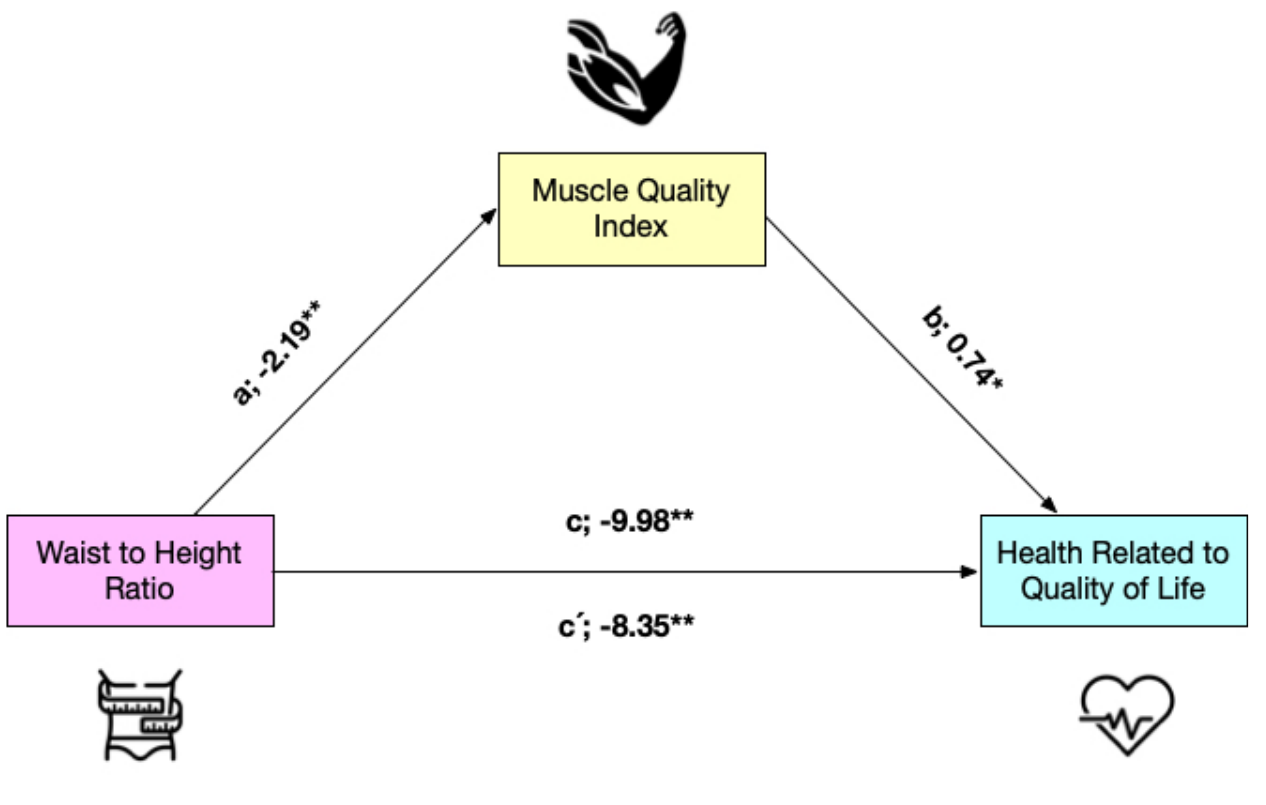
Figure 3. Mediation model testing whether the association between waist-to-height ratio and health related to quality of life was mediated by muscle quality index. * p < 0.05; ** p < 0.001. Panel A non-adjusted, Panel B adjusted by sex and age.